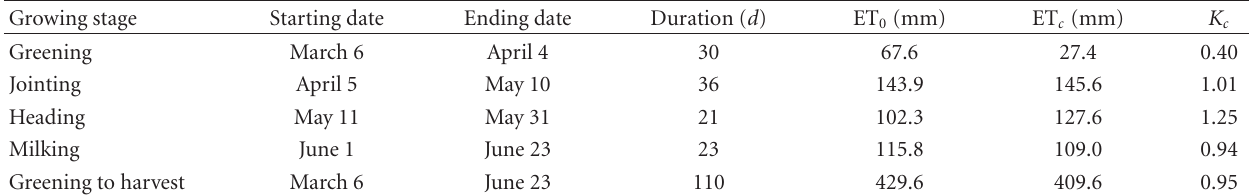
Table 1: Values of reference ( ET 0 ) and crop ( ET c ) evapotranspiration and crop coe ffi cient ( K c ) in growing stages of winter wheat after greening in 2003.